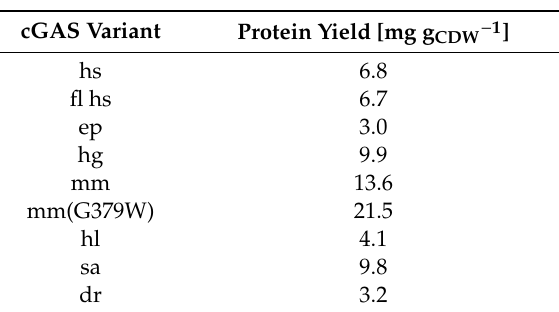
Table A2. Biomass-specific protein yield of heterologous expression of cGAS homologues in Escherichia